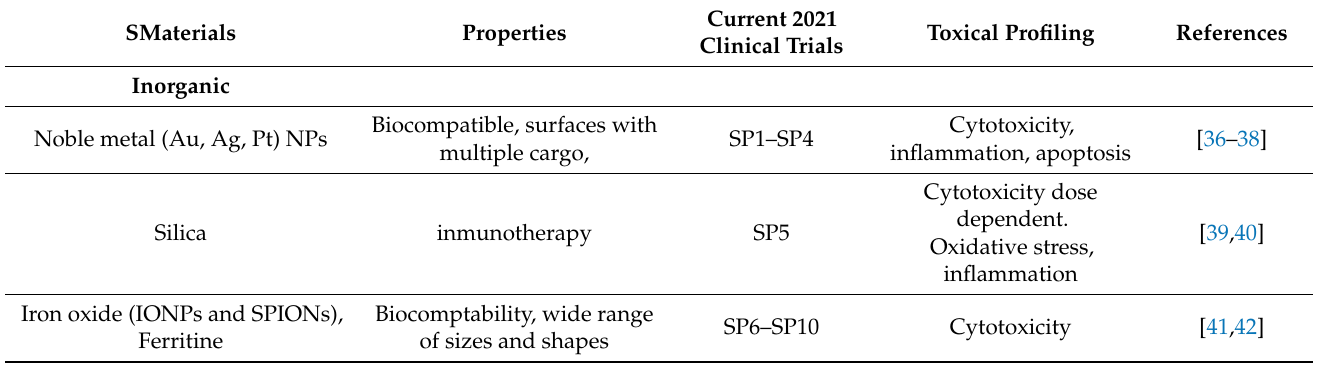
Table 2. Materials and structures evaluated for the transfer of nucleic